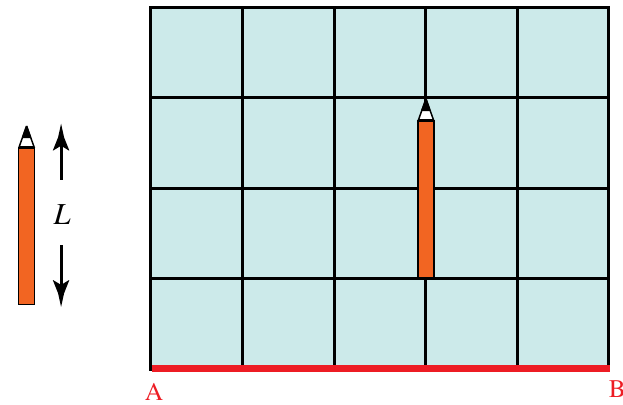
FIG. 6 (color online). Diagram shown to students as part of the pencil task.